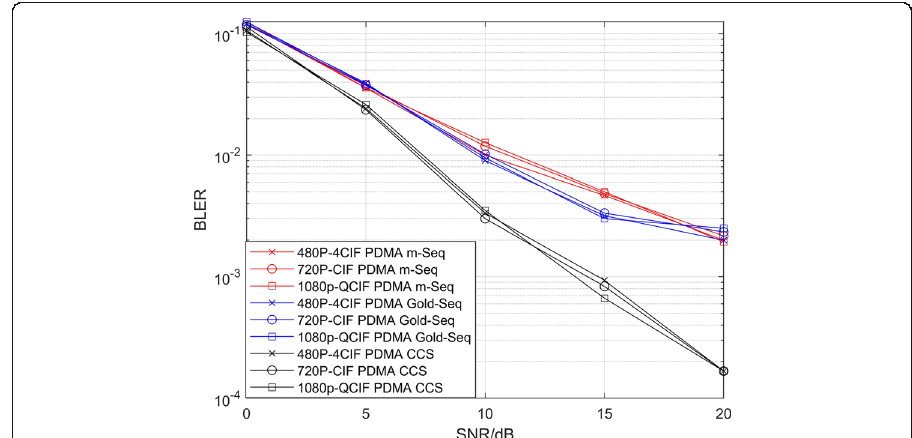
Fig. 11 Dynamic power allocation at different transmission data. The performance comparison of the three